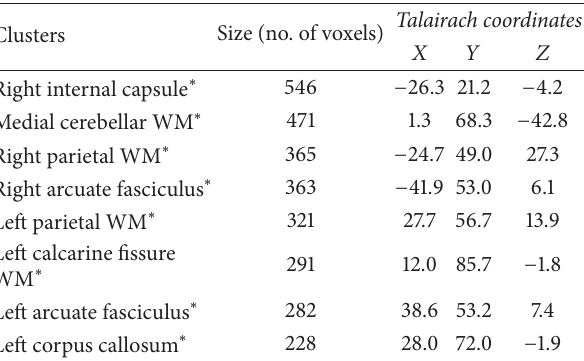
Table 4: Significant clusters of FA reduction among HTN